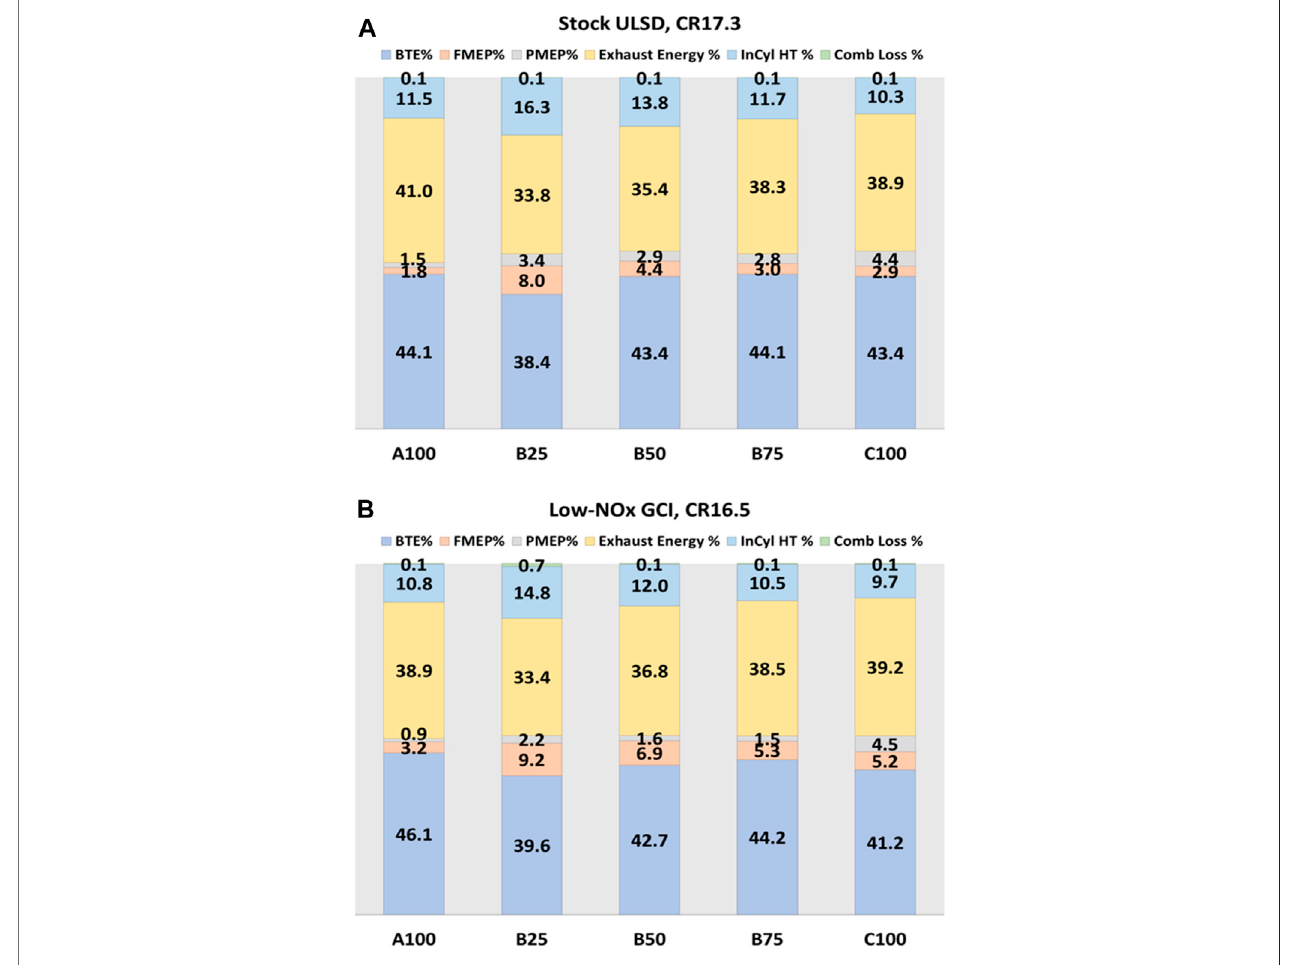
FIGURE 13 | Estimated energy distribution for (A) stock ULSD CR17.3 and (B) low-NOx GCI at CR16.5, at the fi ve key engine conditions.